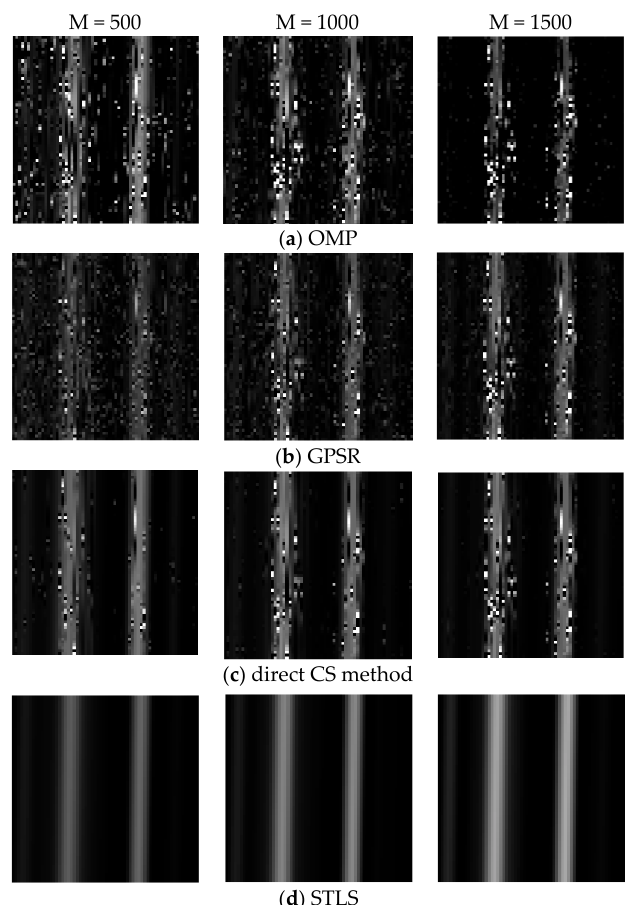
Figure 6. Experimental reconstructed quantum ghost images of the double-slit by ( a ) OMP, ( b ) GPSR, ( c ) Method proposed in [19] and ( d ) STLS.